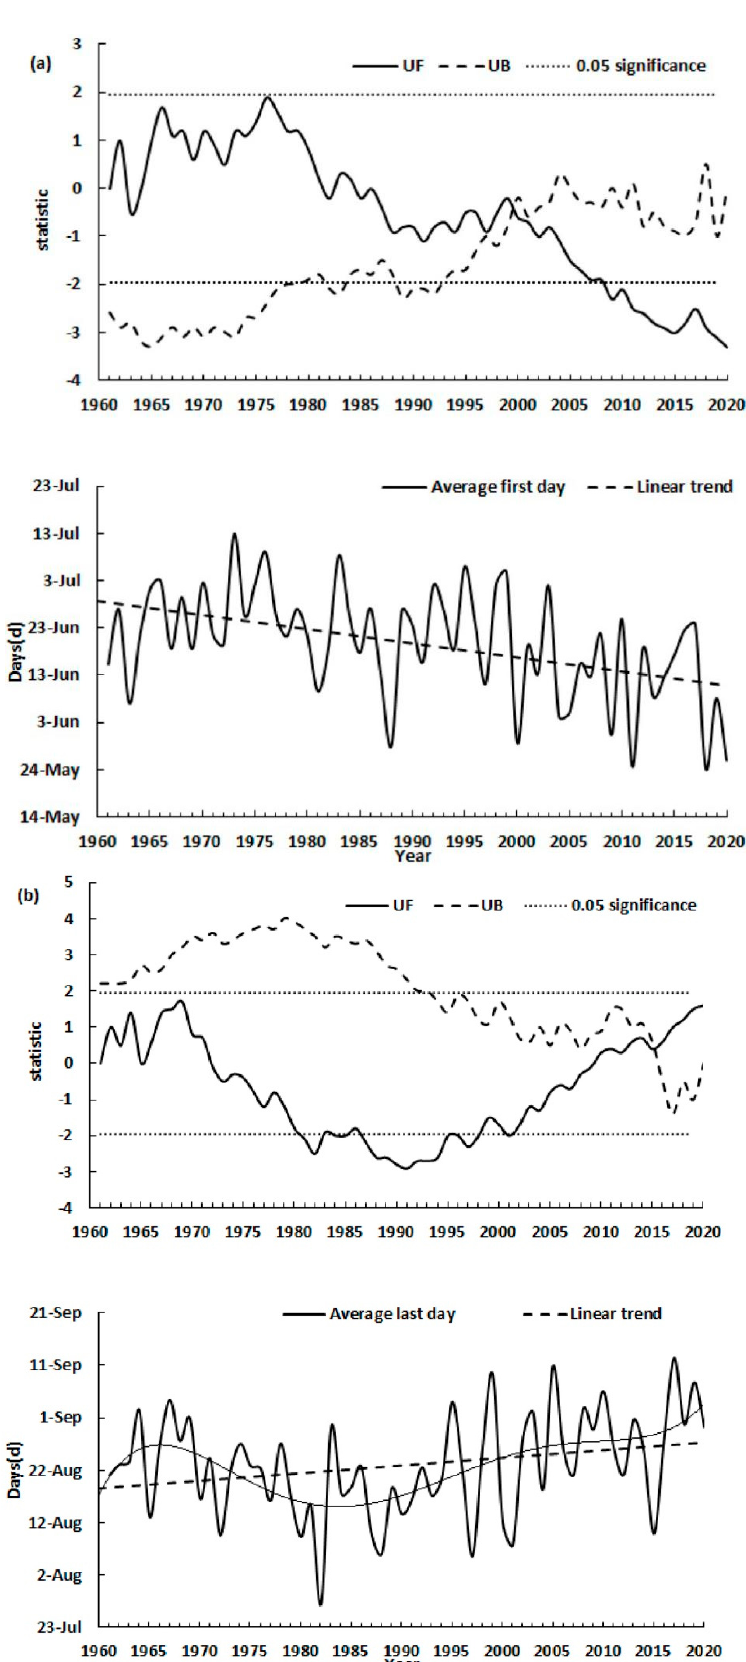
Figure 9. Variation trend and Mann–Kendall calculation of the mean ( a ) first and ( b ) last extreme maximum temperature event days in East China during the period 1961–2020.